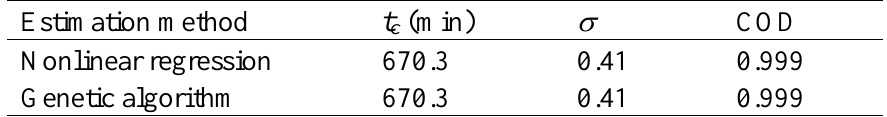
Table 7. Parameter estimation in the Belter-Cussler-Hu equation by the nonlinear regression and GA